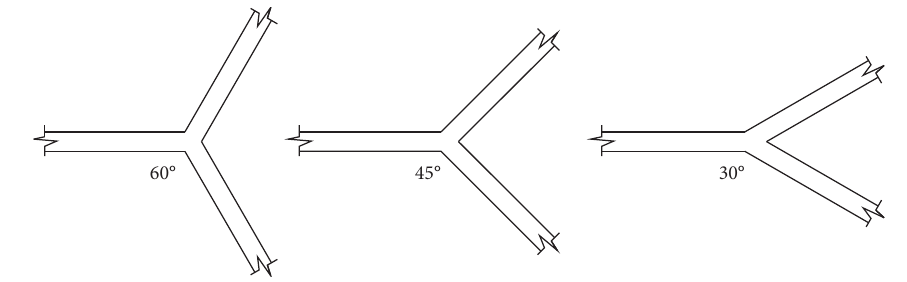
Figure 28: Y-shaped connections with different branch angles. Table 17: Parameters of Y-shaped connection in different cases.